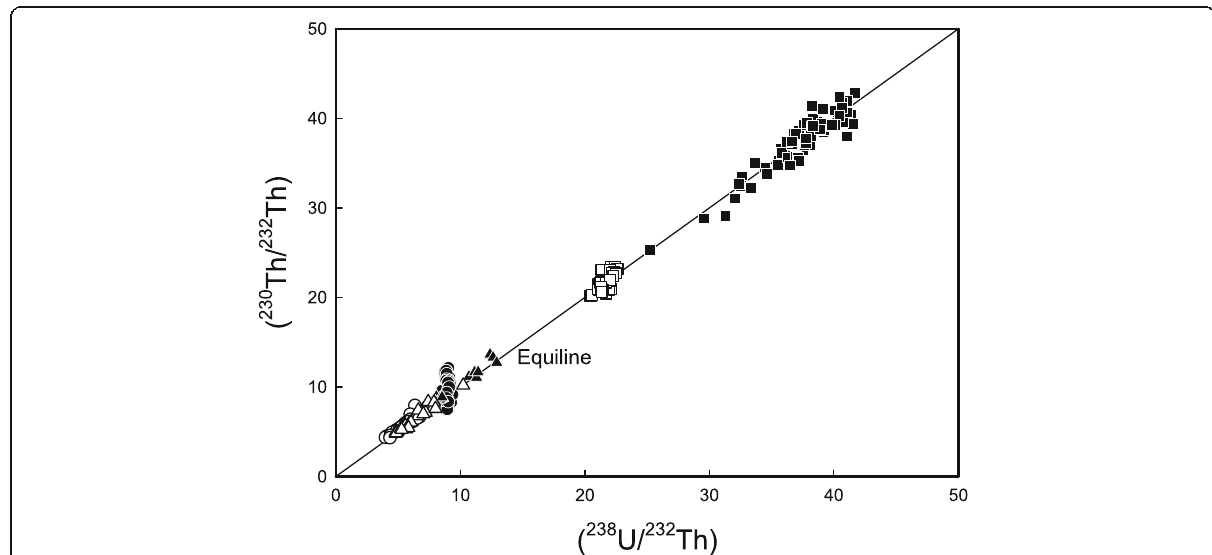
Fig. 5 230 Th/ 232 Th vs. 238 U/ 232 Th activity ratios for the reference zircon materials and KBSI working standards. Note that all zircons demonstrate secular equilibrium and plot along the equiline. Symbols are the same as in Fig.